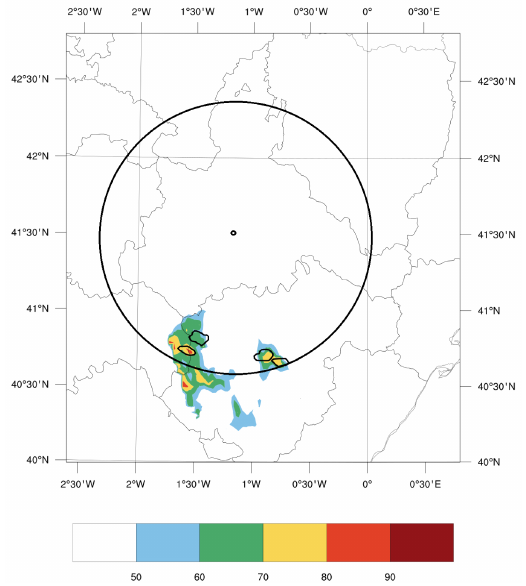
Fig. 7. 14:00UTC on 12 August 2011. Color scale: HDT outputs in terms of hail probability. Black contours: radar-based hail precipi- tation. Circled area shows the 110km radar